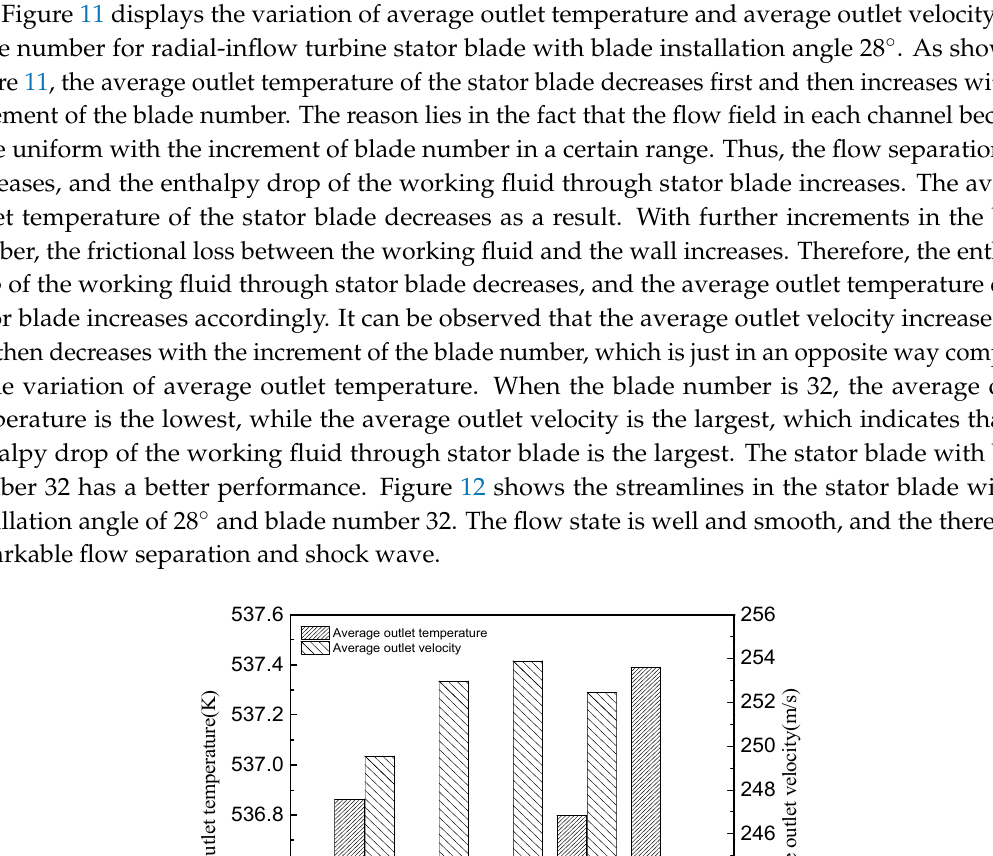
Figure 10. Average outlet temperature and average outlet velocity for stator blade with blade number 32.